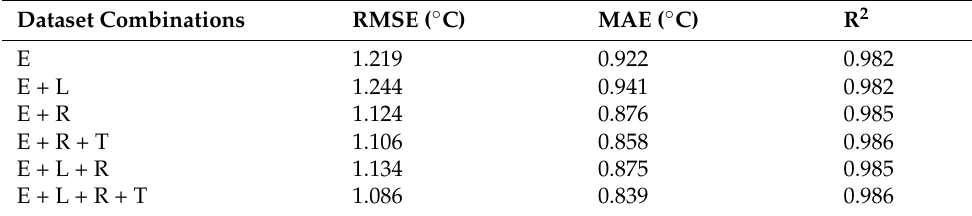
Table 5. Model accuracy for different combinations of datasets. E: ERA5-Land data; L: TRIMS LST; R: Remotely Sensed Products; T: Temporal